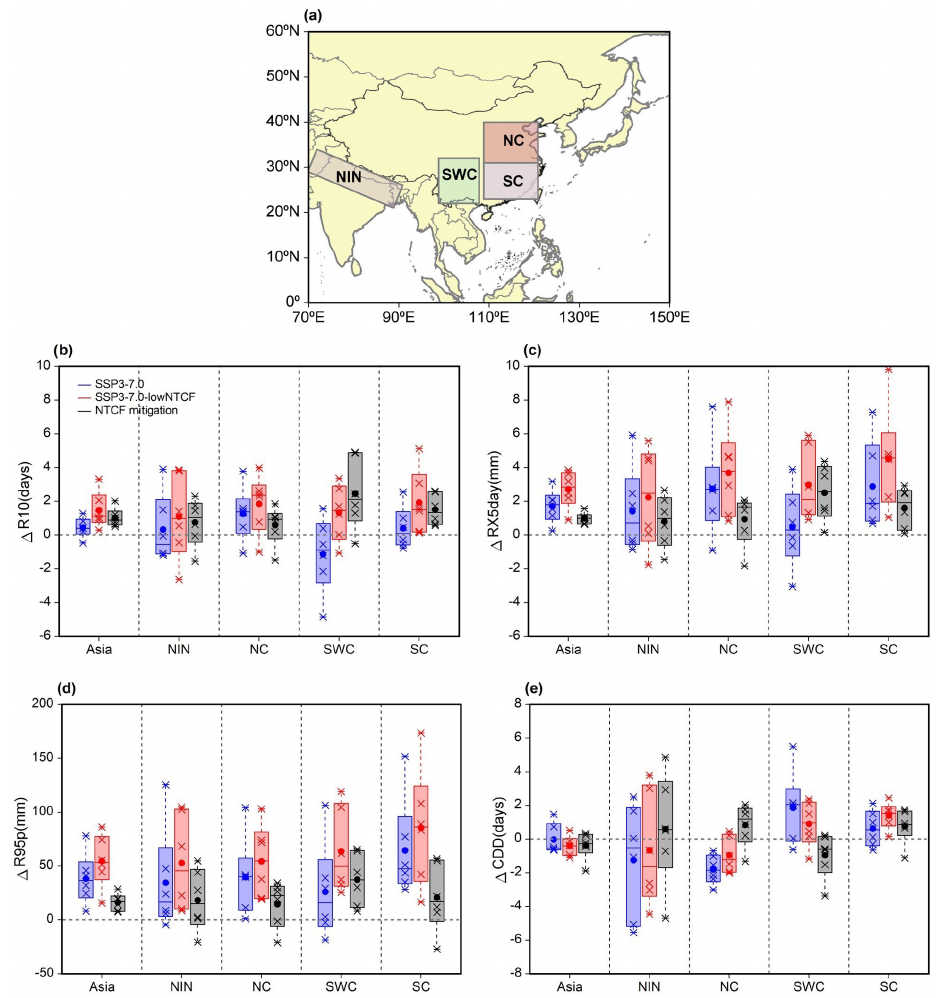
Figure 11. Changes in heavy precipitation (R10; b ), maximum consecutive 5d precipitation (RX5day; c ), total wet-day precipitation (R95p; d ), and consecutive dry days (CDDs; e ) averaged over NIN, NC, SC, and SCB (a) during 2031–2050 relative to 1995–2014 under the SSP3- 7.0 (red) and SSP3-7.0-lowNTCF (blue) scenarios. The grey bars represent the changes caused by the non-methane SLCF reductions. The star symbols indicate the individual models, and the boxes indicate the spread from the 25th to the 75th percentile of the models, with the centre lines representing the median and the dot representing the mean